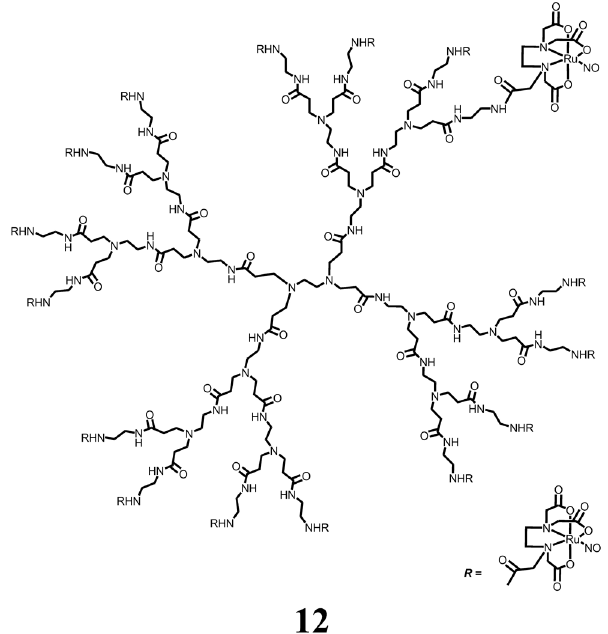
FIGURE 5 - PAMAM dendrimer generation 2 (G2/RuNO) functionalized with [Ru(edta)NO] - . (Benini, McGarvey, Franco,